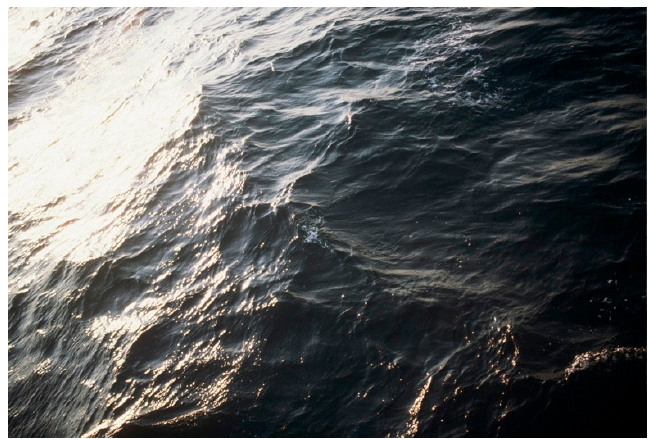
Figure 4. A close view of wind waves in generation conditions. Note the tendency of the crest to be curved, with the crest central point ahead.